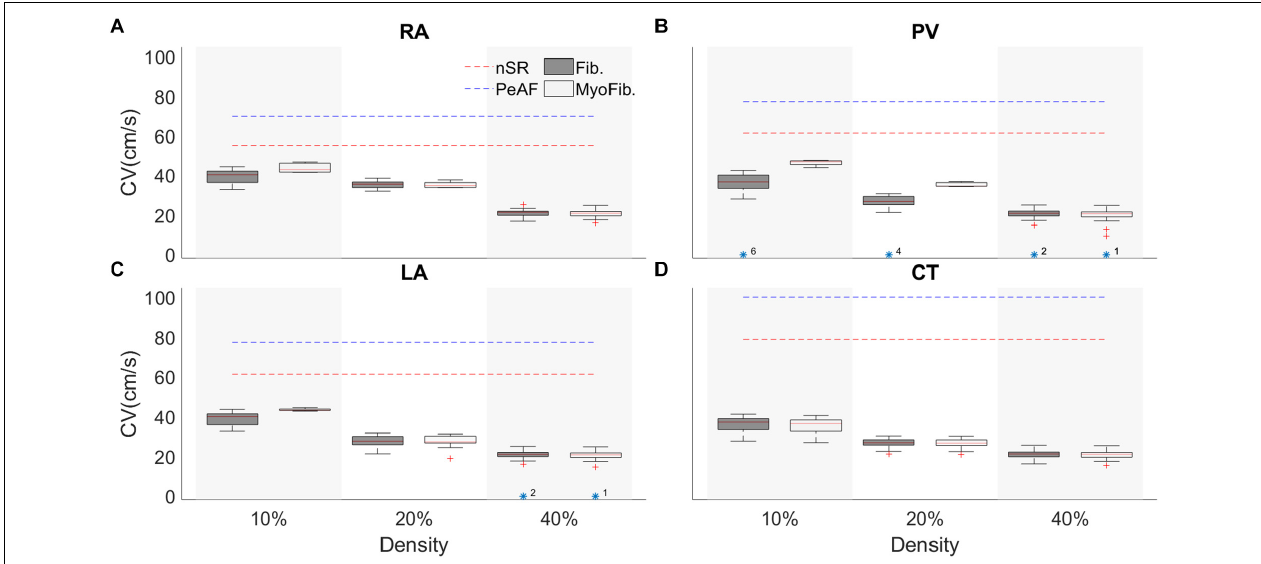
FIGURE 6 | Conduction velocity (CV) of a tissue strand in four different regions of the atria with random fibroblasts (Fib) or myofibroblast (MyoFib) distribution and different fibroblast densities. For each density 100 random configurations were simulated. CV measurements are represented in boxplots. (A) Right atria (RA).